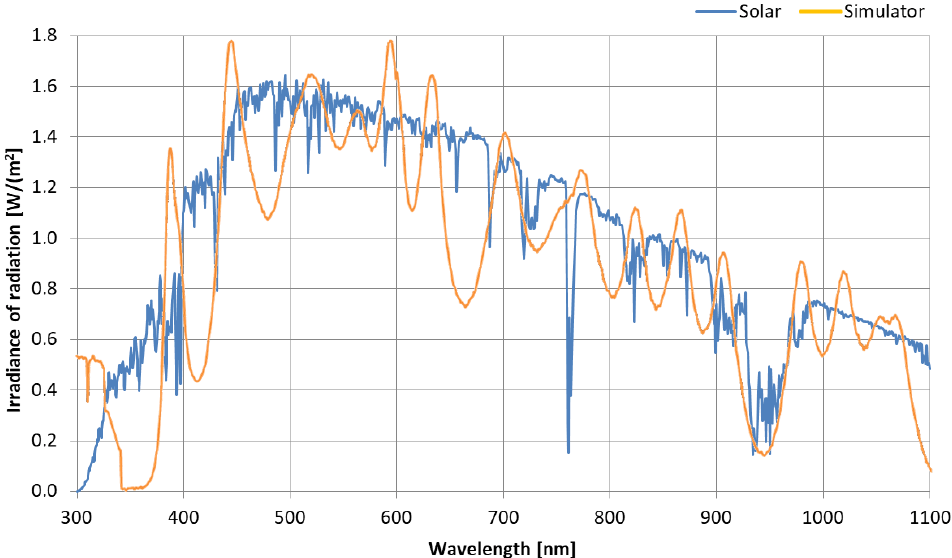
Figure 3. The radiation distribution obtained in the test bench set against the solar radiation distribution. Due to the fact that the testing methodology assumes inducing a unidirectional heat flow from the top surface of the sample to its bottom it was necessary to limit the heat transfer between the sample and the environment. These conditions, as determined above, have been provided by equipping the test bench shown in Figure 4a with thermally isolated chamber (made with mineral wool and aluminum foil) and the steel plate designed to reflect light rays (only the upper part of the sample is exposed to direct radiation) shown in Figure